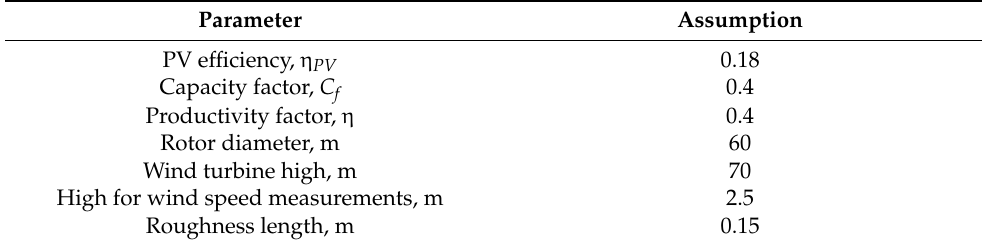
Table 1. The main technical assumptions for RES technologies.